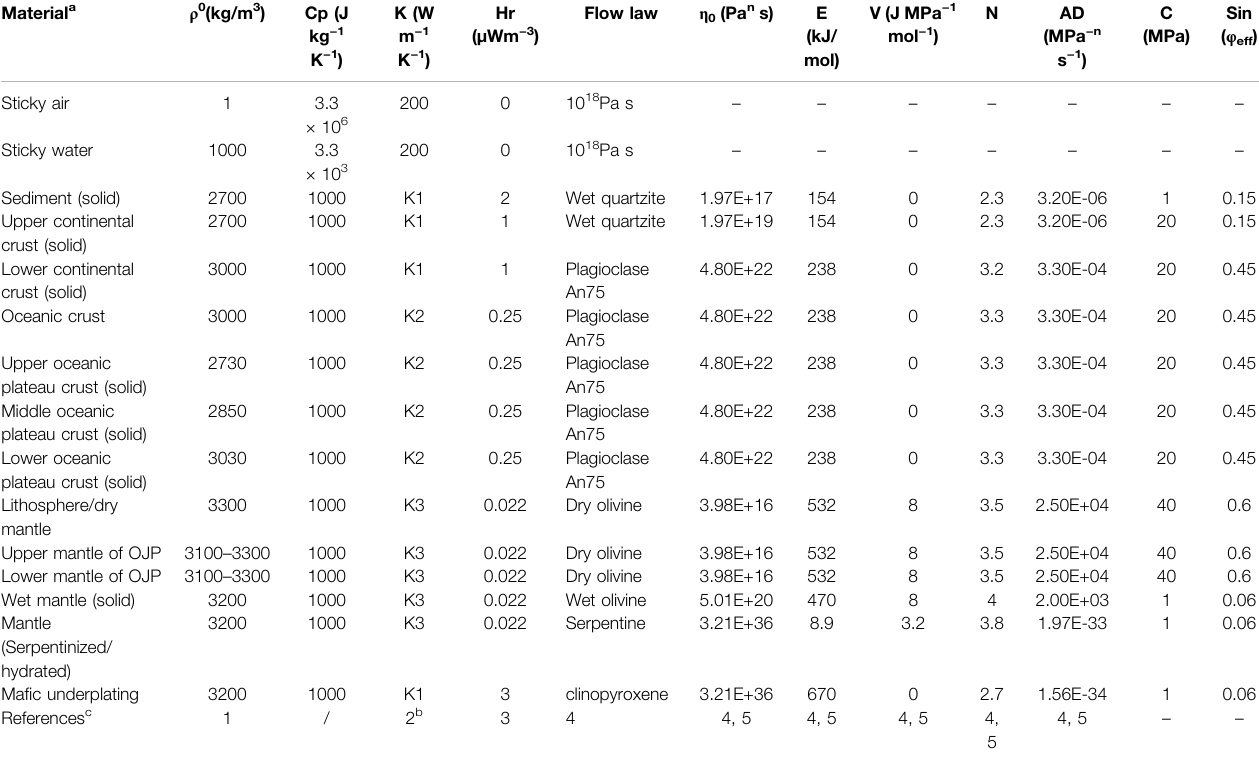
TABLE 1 | Physical parameters in the model. Material